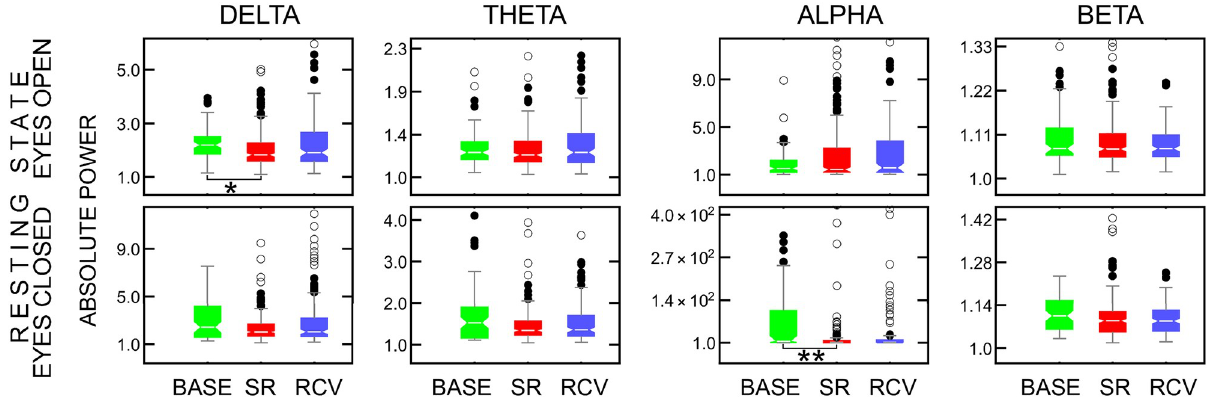
Fig 7. The absolute power of δ , θ , α , and β waves for resting state with eyes open (top row) and closed (bottom row), as in Fig 6, jointly from channels O1 and O2. The p-values for differences at each channel can be found in Table 3 in S1 File.